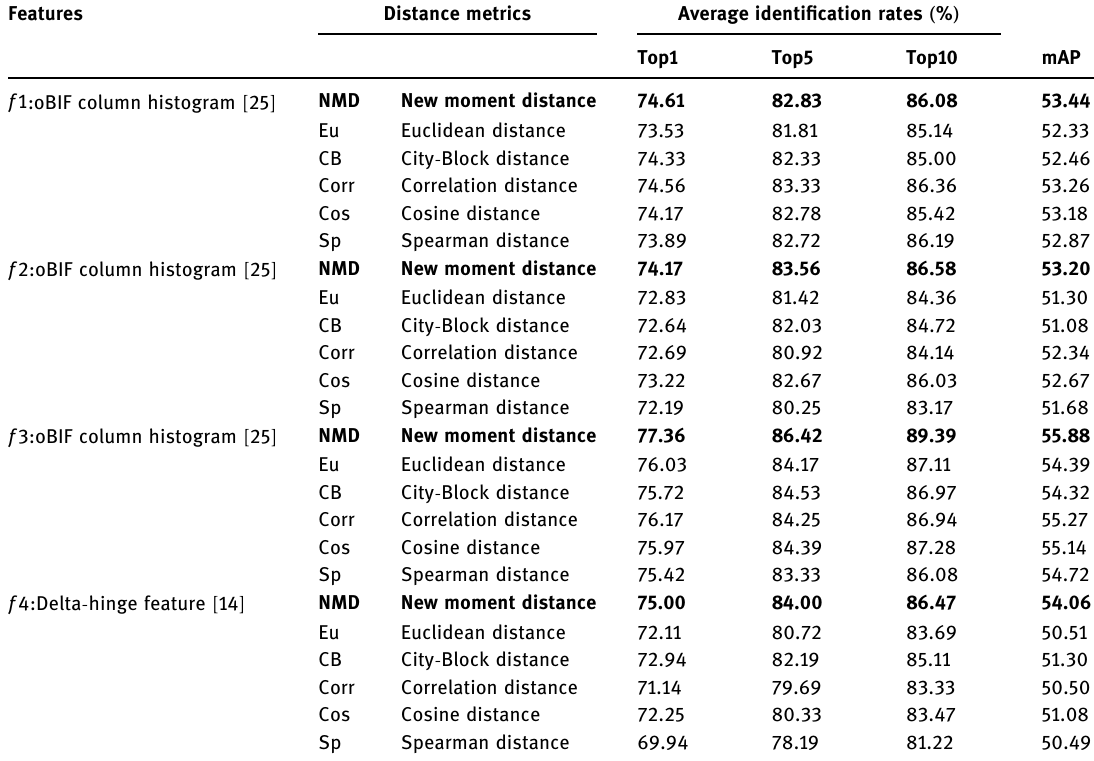
Table 3: Performance of oBIF column histograms and delta - hinge features with di ff erent distance metrics